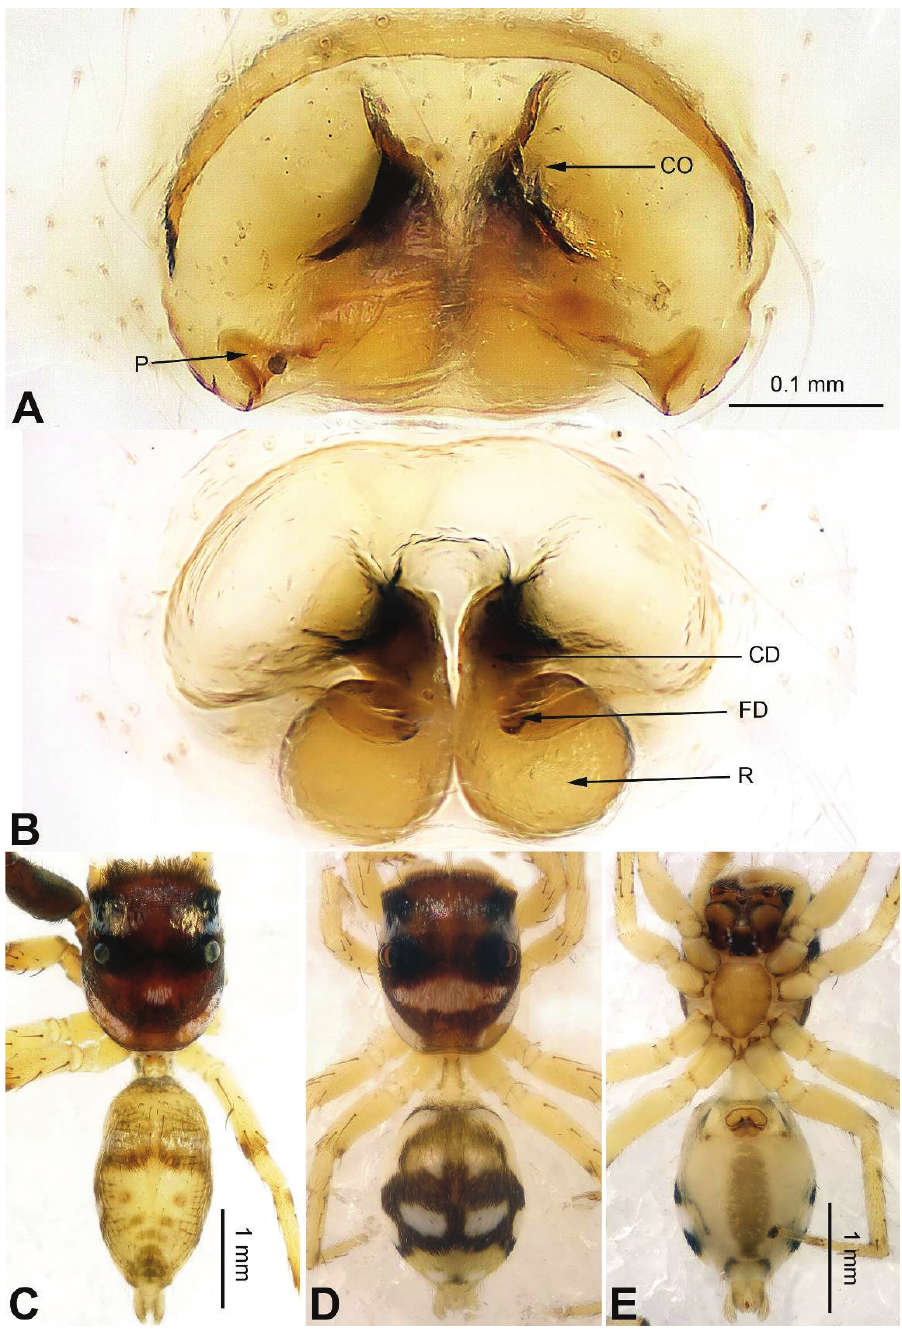
Figure 33. Phintella lepidus sp. n., female paratype and male holotype. A epigyne, ventral B vulva, dorsal C male habitus, dorsal D female habitus, dorsal E female habitus, ventral. Scale bars equal for A and B ; equal for D and E